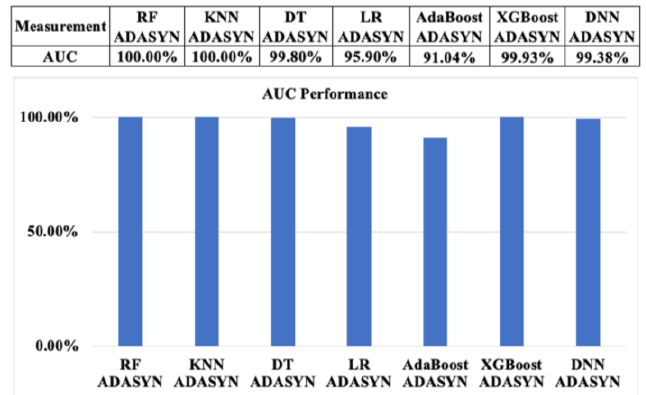
Figure 17. AUC measurement performance of machine learning algorithms with ADASYN SMOTE based on resampling approach 1.